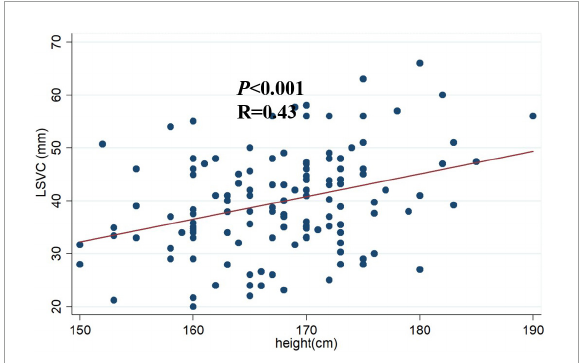
FIGURE3 Scatter plot of height and LSVC. A significant linear relationship between myocardial sleeve length and height ( R = 0.43, p < 0.001). LSVC: SVC myocardial sleeve